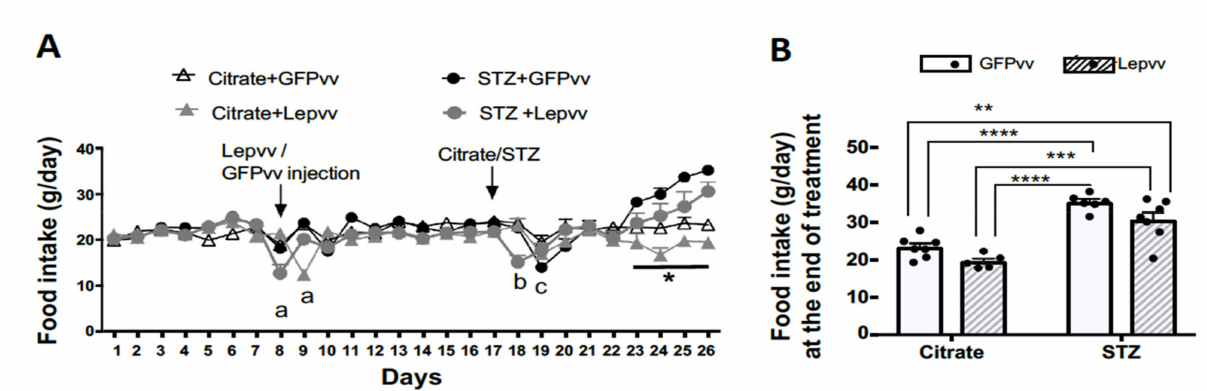
Figure 1. Food intake changes in male rats that were injected with Lepvv or GFPvv on day 8 followed by injection with citrate buffer or STZ (to induced diabetes) on day 17. ( A ) Profile of food intake (g/day, mean ± SEM) in diabetic and non-diabetic rats treated with Lepvv or GFPvv. Citrate + GFPvv ( n = 7); STZ + GFPvv ( n = 6); Citrate + Lepvv ( n = 5) and STZ + Lepvv ( n = 7) are represented. Data were analyzed using linear mixed models as described under Statistics. “a” indicates significant difference ( p < 0.01) between Lepvv-injected rats and the other groups on days 8–9, “b” indicates significant difference ( p < 0.0001) between diabetic rats injected with Lepvv and the other groups on day 18 and “c” indicates difference between GFPvv-injected diabetic and non-diabetic rats on day 19 ( p < 0.01). * indicates p < 0.05 between Lepvv + citrate group and the other groups. ( B ) Average food intake on the 9th day after STZ/citrate injection (g, mean ± SEM). Data were analyzed by 2-way ANOVA followed by Tukey’s multiple comparisons test. Food intake was significantly reduced in the GFPvv-treated diabetic group compared to the citrate groups (**** p < 0.0001). Food intake in the Lepvv-treated diabetic animals was also increased compared to the citrate groups, but to a lesser extent (** p < 0.01; *** p < 0.001).